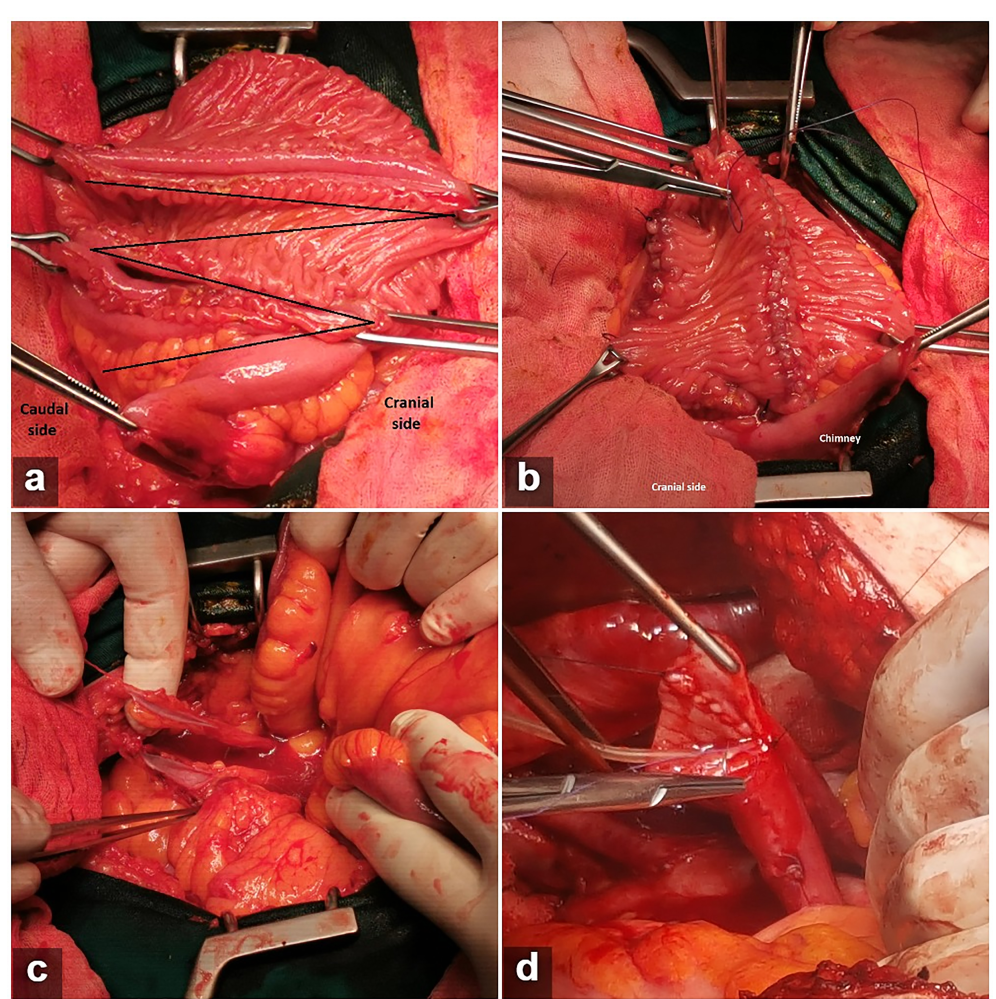
Figure 1 - Construction of the reservoir: a) four folds of ileum were arranged in the shape of a ‘W’ using four traction points, with a 6-8cm long chimney situated on the left side of the ‘W’. Base of the "W" is oriented cranially; b) Folding of the posterior plate: an ileal plate is formed from the ‘W’ by sewing together the cut edges of the antimesenteric borders using absorbable running suture on a straight needle. Chimney is positioned on the left side of the plate; c) Ureters were spatulated for an average of 3-4cm, with maximum length of a healthy ureter and periureteral fatty tissue preserved on both sides; d) conjoined ureters sec. Wallace